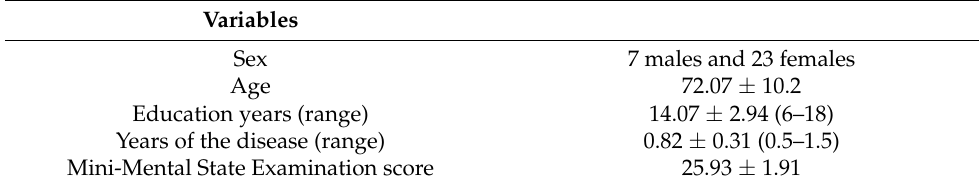
Table 1. Baseline characteristics of the study participants.